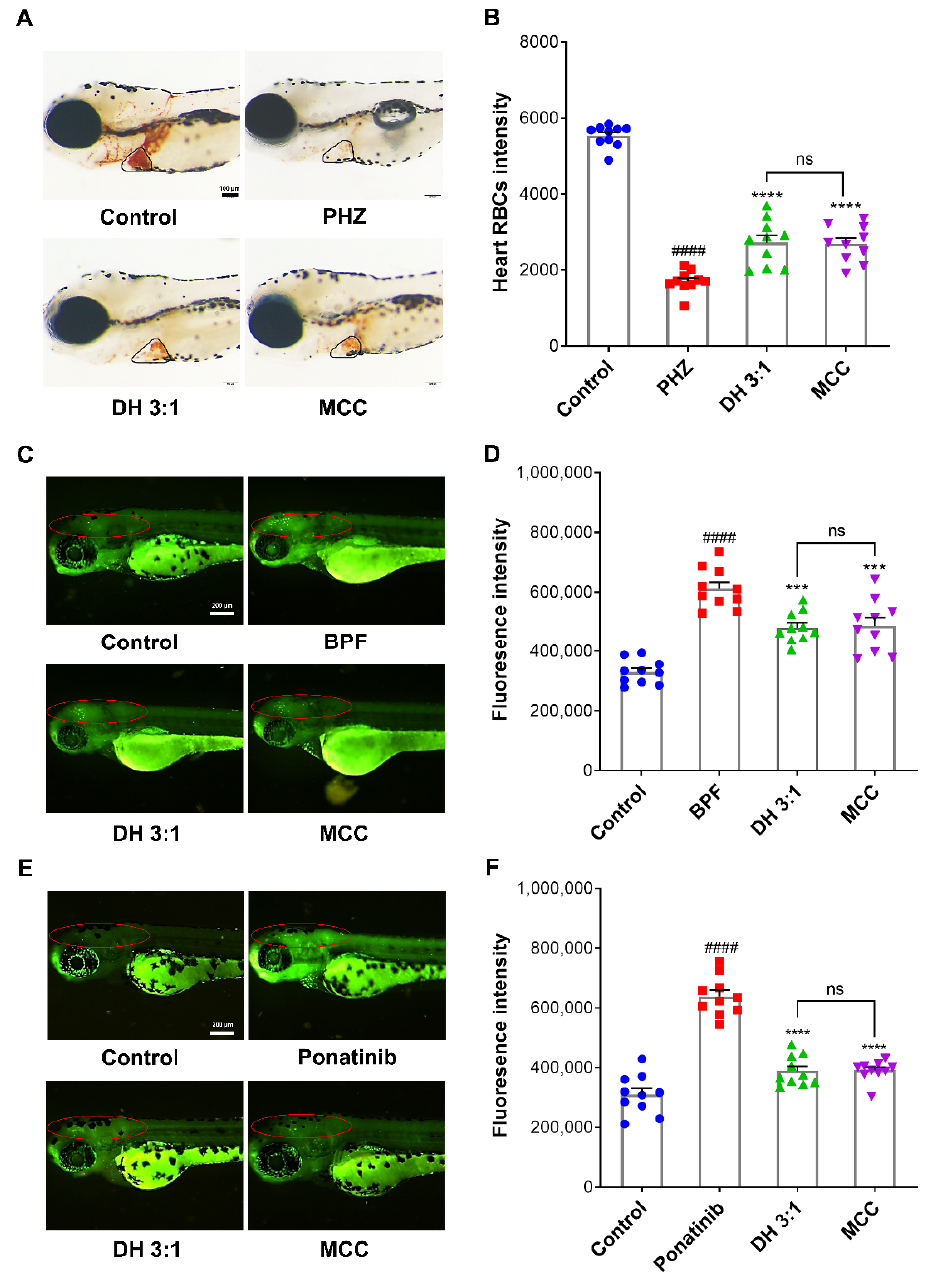
Figure 5. The multi-component combination (MCC) improved thrombosis and neuronal injury in zebrafish. ( A , B ) Zebrafish thrombosis was induced by PHZ (1.5 µ M), and the antithrombotic efficacy of the DH herbal pair and MCC was evaluated by calculating the heart RBC intensity (in the black circle) with the Image Pro Plus 6.0 software. ( C , D ) The zebrafish neurological injury model was induced by BPF (10 µ g/mL). ( E , F ) The zebrafish ischemic stroke model was induced by ponatinib (1 μ g/mL). The neuroprotective efficacy of the DH herbal pair and MCC was analyzed by calculating the fluorescence intensity in the zebrafish brains (in the red circle) with the Image J software. The data are presented as mean ± SEM (n = 10). DH: Danshen-Honghua *** p < 0.001, **** p < 0.0001 vs. model group; #### p < 0.0001 vs. control group; ns: no significant difference.